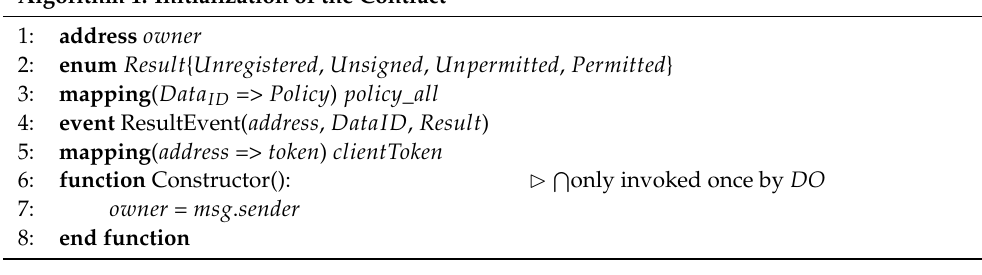
Algorithm 1. Initialization of the Contract